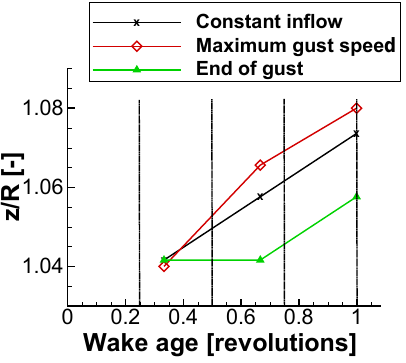
Figure 13. Tip vortex transportation vertical to main flow direction with dependence on the wake age at three time instances during the